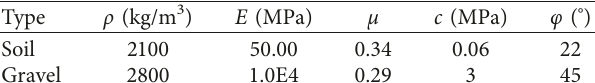
Table 1: Basic physical and mechanical parameters of soil and gravel.